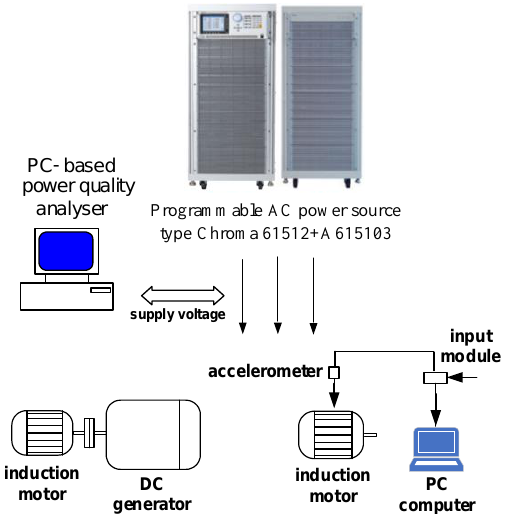
Figure 2. Simplified diagram of the measurement stand.